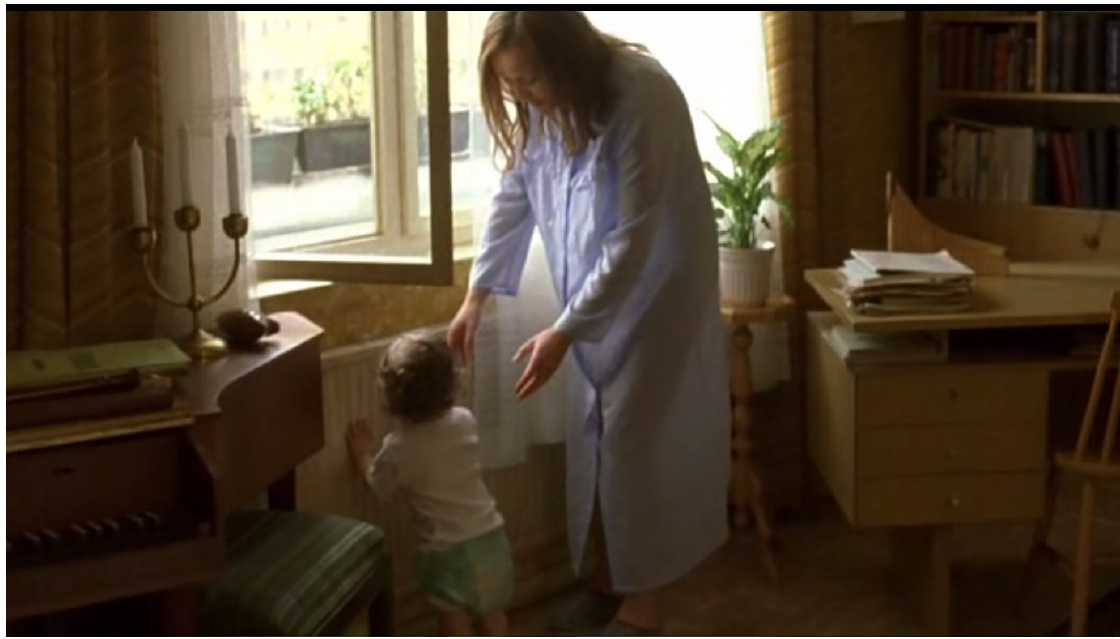
Figure 7 Grandmother and granddaughter start to walk together.